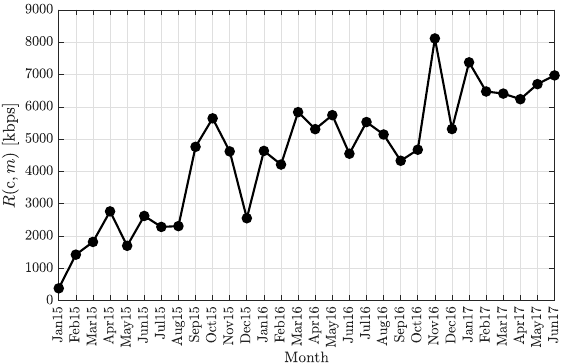
Figure 1. Evolution of monthly busy-hour traffic in a